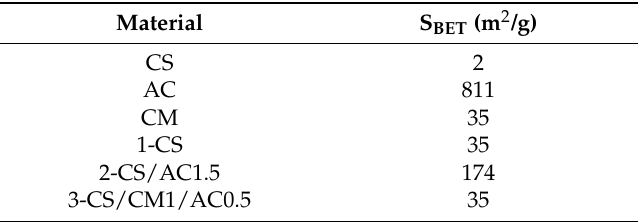
Table 3. BET Specific surface area (S BET ) of the raw and hybrid